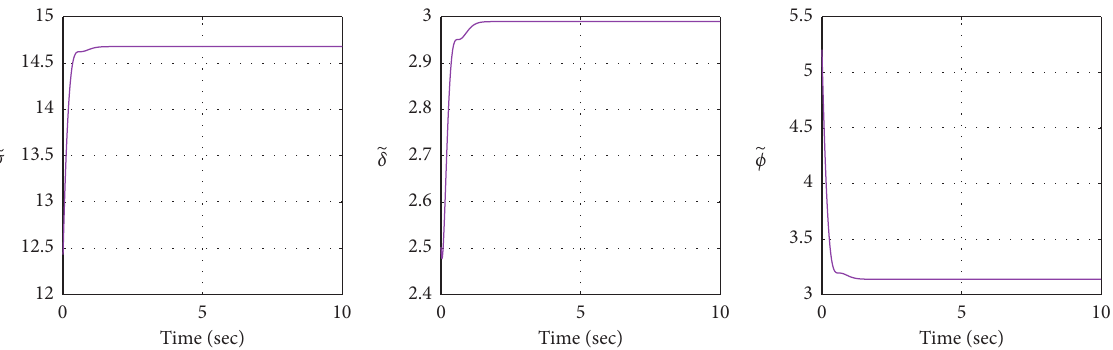
, c , and c ) over time. 1 2 3